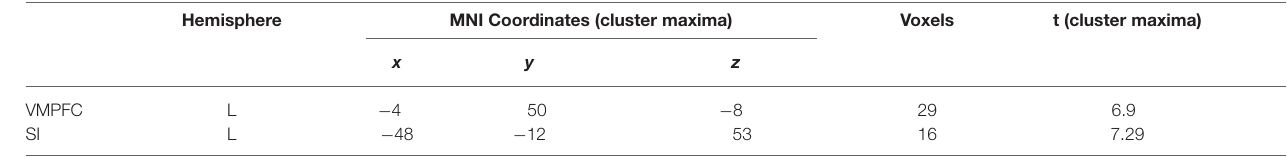
TABLE 3 | Significant group ALFF differences for the acupuncturist group (p FWE < 0.05) .